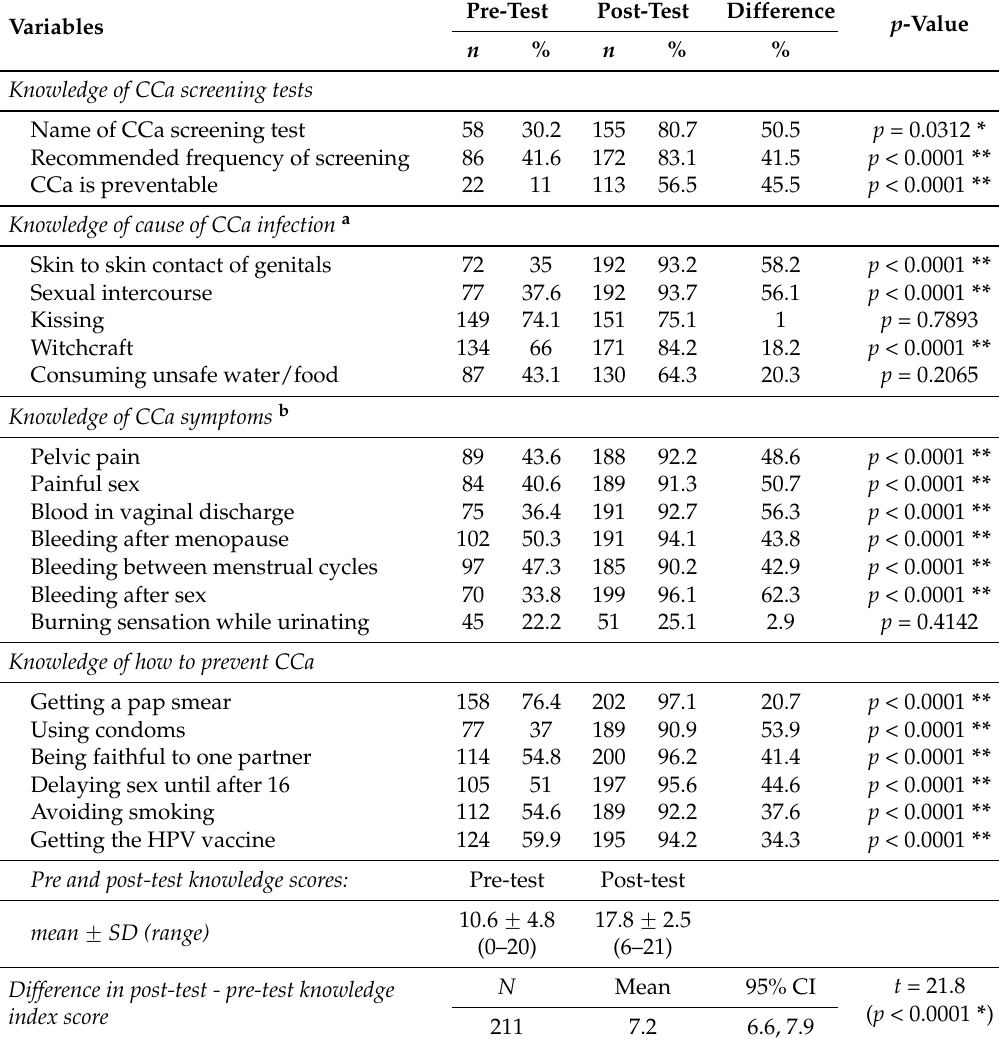
Table 4. Knowledge of screening tests, risk factors, symptoms, prevention and intention to